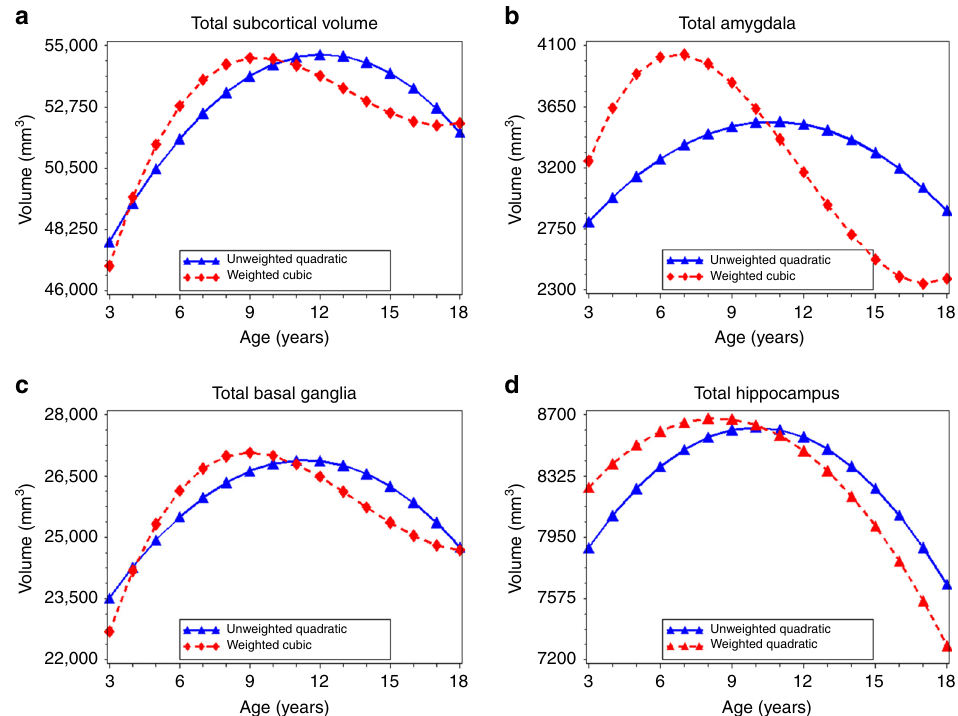
Fig. 5 Age-related variation in subcortical volume. Using the best- fi tting regression models described in Table 2, we calculated the predicted values by age for: total subcortical volume ( a ), total amygdala volume ( b ), total basal ganglia volume ( c ), and total hippocampal volume ( d ), in the unweighted ( blue lines ) and weighted ( red lines )